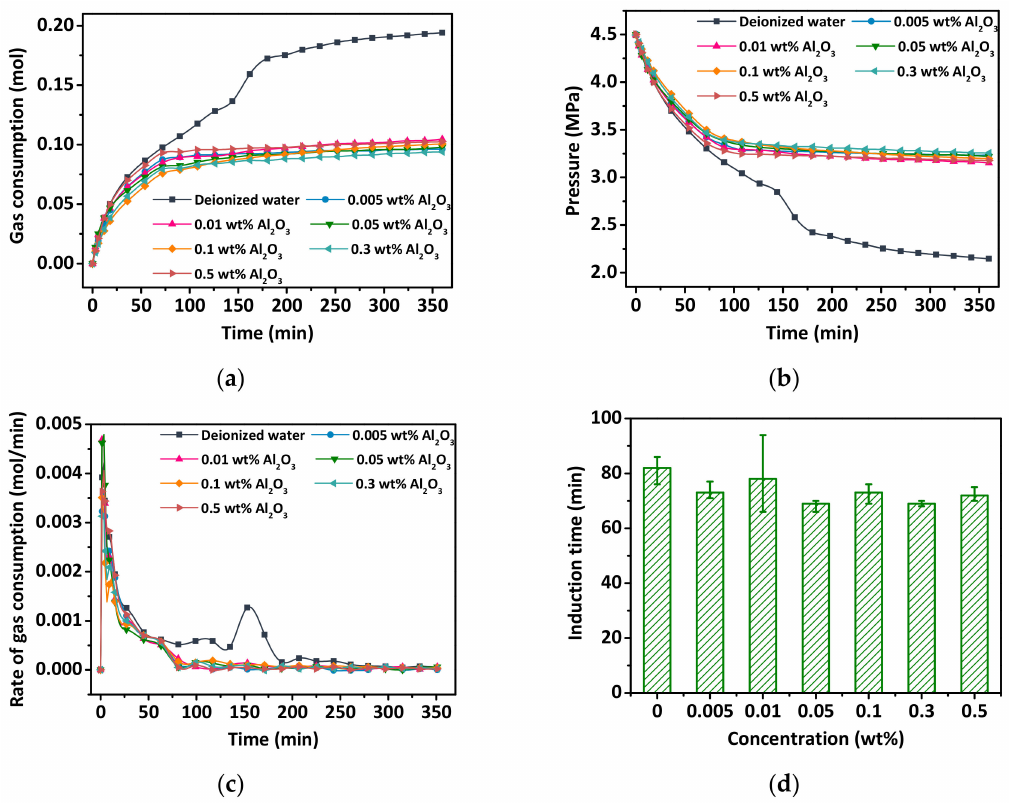
Figure 7. ( a ) The gas consumption, ( b ) the pressure drop, ( c ) the gas consumption rate and ( d ) the induction time during CO 2 hydrate formation in the various Al 2 O 3 nanoparticle suspensions at the di ff erent